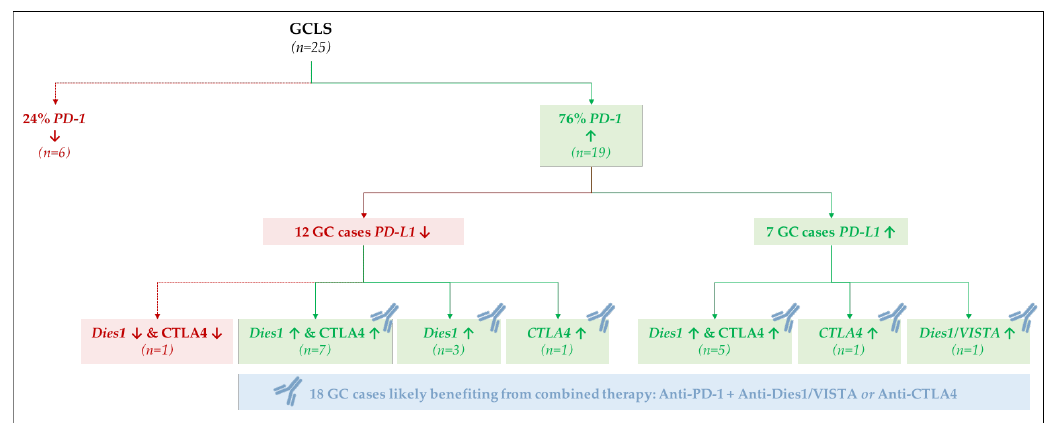
Figure 8. mRNA co-expression patterns for PD-1 , PD-L1 , Dies1/VISTA and CTLA4 in GCLS cases.